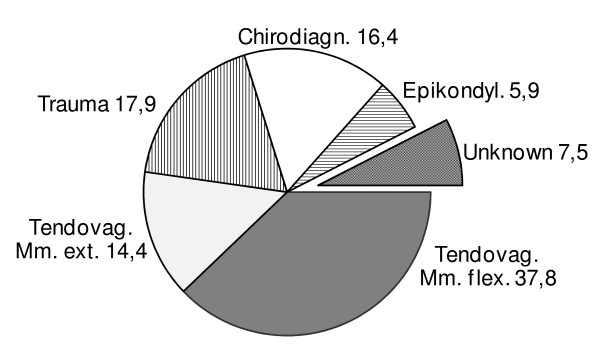
Diagnosis rates [%].